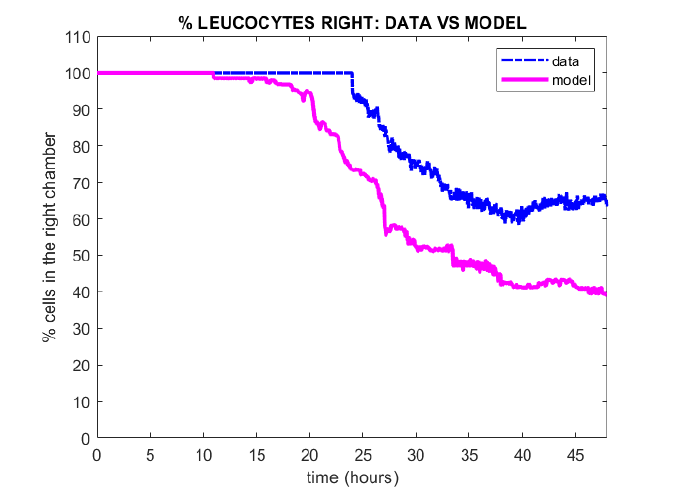
Figure 6. Plot of the percentage of leukocytes in the right chamber detected experimentally (blue dotted line) vs the percentage of leukocytes in the right chamber obtained by once simulating the mathematical model (3)–(5), (magenta